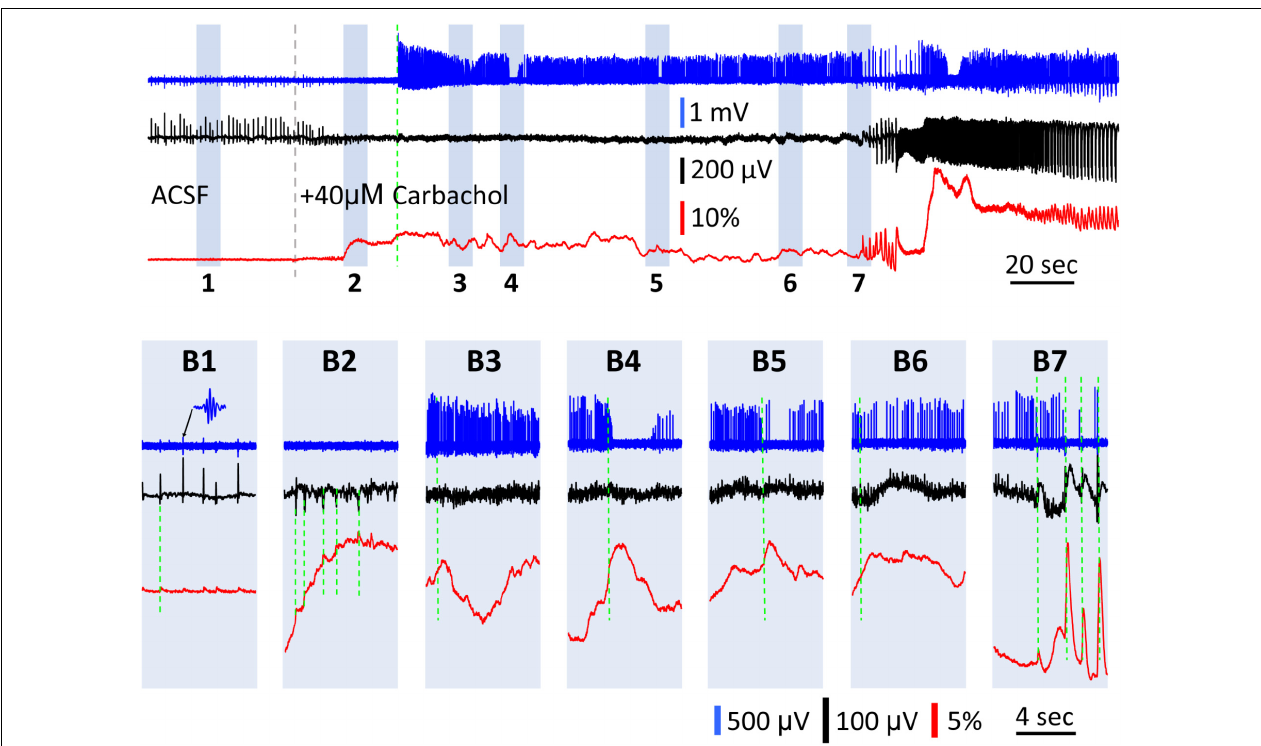
FIGURE 6 | GCaMP signals during the transition between SWs and carbachol induced bursts. (A) A 5 min recording of the transition period between spontaneous SWs and carbachol-induced theta oscillations. Blue trace shows the LFP filtered between 60–1,500 Hz (data sampled at 3,000 Hz), to isolate neuronal spikes from nearby cells. Black trace shows the LFP filtered between 0.1–30 Hz to isolate SWs (initial period) and theta bursts (final period). Red trace shows the GCaMP signal filtered between 0.1–30 Hz. Gray broken line marks the onset of 40 µ M carbachol perfusion. Green broken line marks the onset of high spiking activity in the filtered blue trace. Particular periods of interest highlighted 1–7 to display on expanded time scale in panels (B) . (B1) Spontaneous SWs with coincident low amplitude GCaMP peaks (green dashed line) and nested ripple oscillations (inset) before carbachol administration. After carbachol administration, the GCaMP signal had slow and large fluctuations up to (cid:49) F / F = 30%, or about 40 times the SW signals (B2–B6) . (B2) A period showing one-to-one correlations between observed peaks in the GCaMP and LFP signals (green dashed lines). (B3–B6) Periods showing minimal correlation between LFP and GCaMP fluctuations (comparing black and red traces, green dashed line marks onset of GCaMP peaks). (B4,B5) Periods showing anti-correlation between spiking rate and GCaMP fluctuations (comparing blue and red traces, green dashed line marks onset of GCaMP peaks). (B7) Onset of theta oscillations, showing large GCaMP peaks, high correlations between LFP and GCaMP, and synchronous bursts of